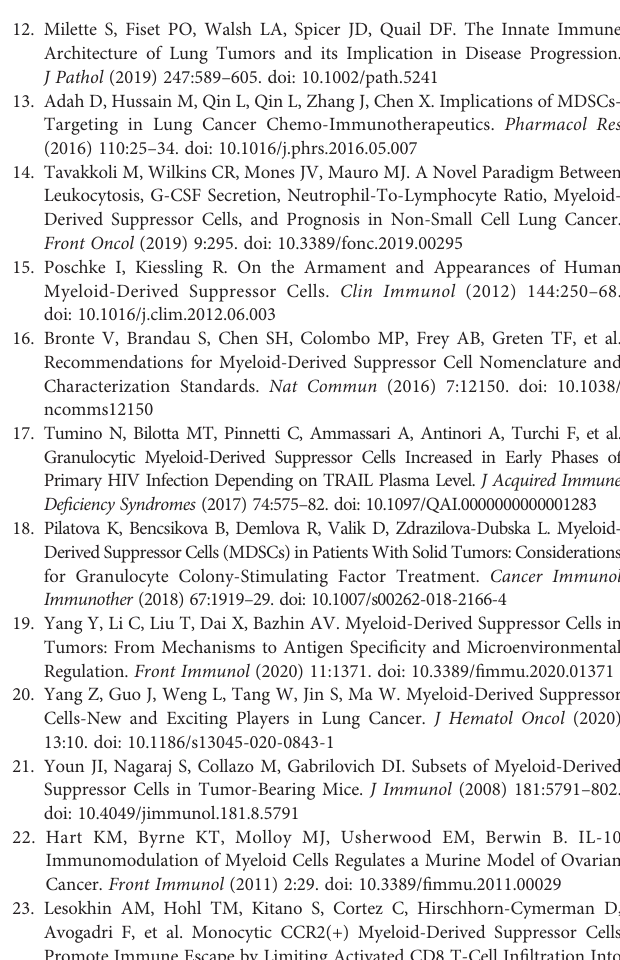
Supplementary Figure 2 | (A, B) Mean ± SEM of the indicated markers evaluated by fl ow cytometry on PBMC from (A) ex-vivo HD vs Lung tumor patients (lung) (n = 3) and (B) HD-NK cells cultured alone (NK) or after co-culture (48h) with PMN-MDSC (NK 1/1) of lung tumor patients (n = 4). (C) Expression of the indicated markers on PMN-MDSC of lung tumor patients by fl ow cytometry. (D) Fold of Inhibition of killing mediated by NK cells co-cultured with PMN-MDSC isolated from G-CSF mobilized HD (white bars, n = 4) and from PB of lung tumor patients (black bars, n =